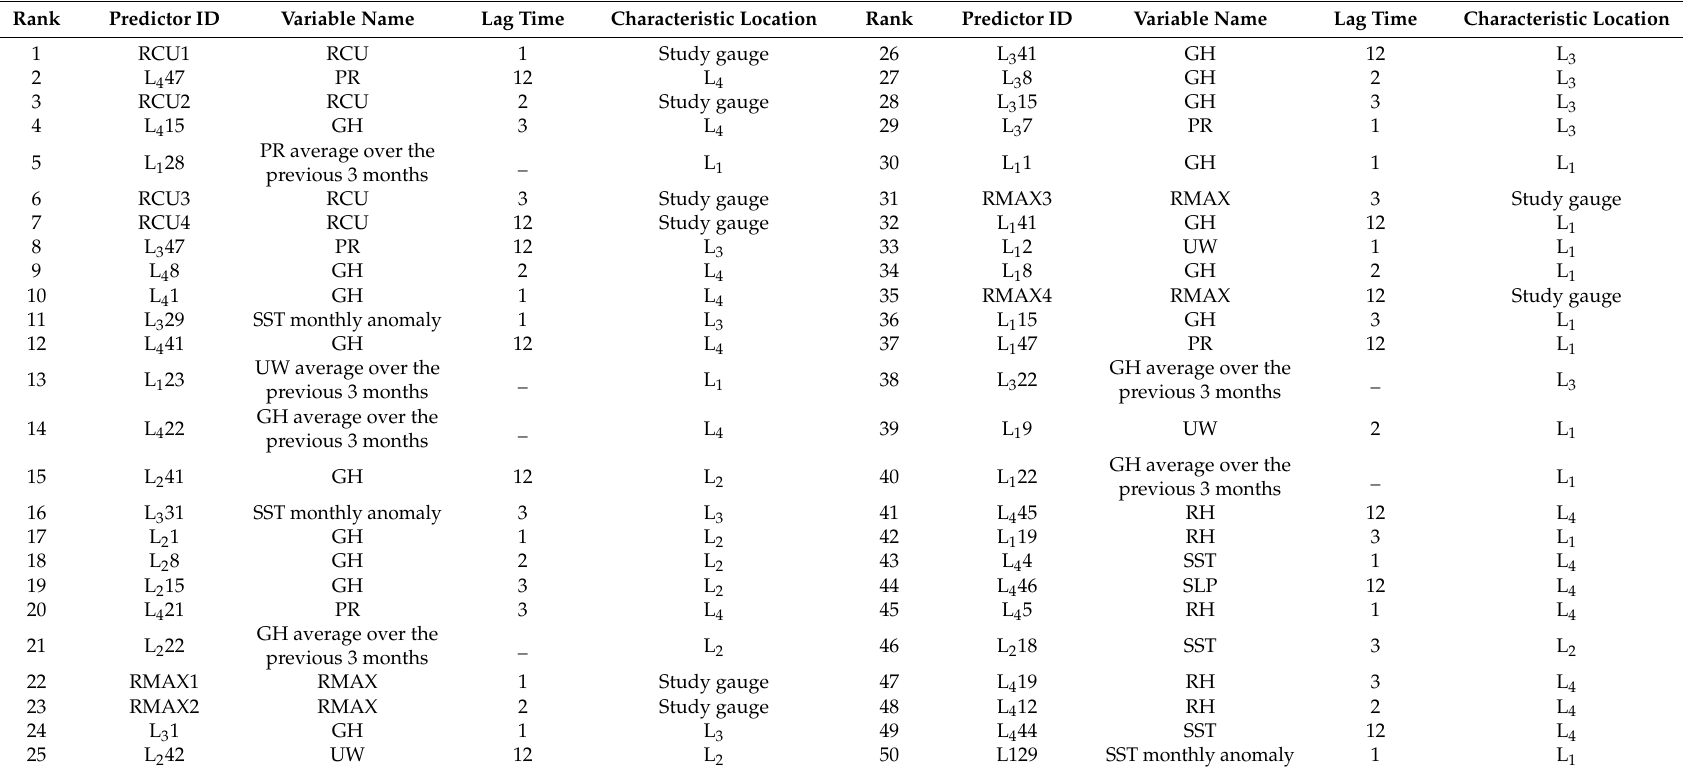
Table 4. Rank and list of the most effective predictors for forecasting RMAX selected based on MRMR